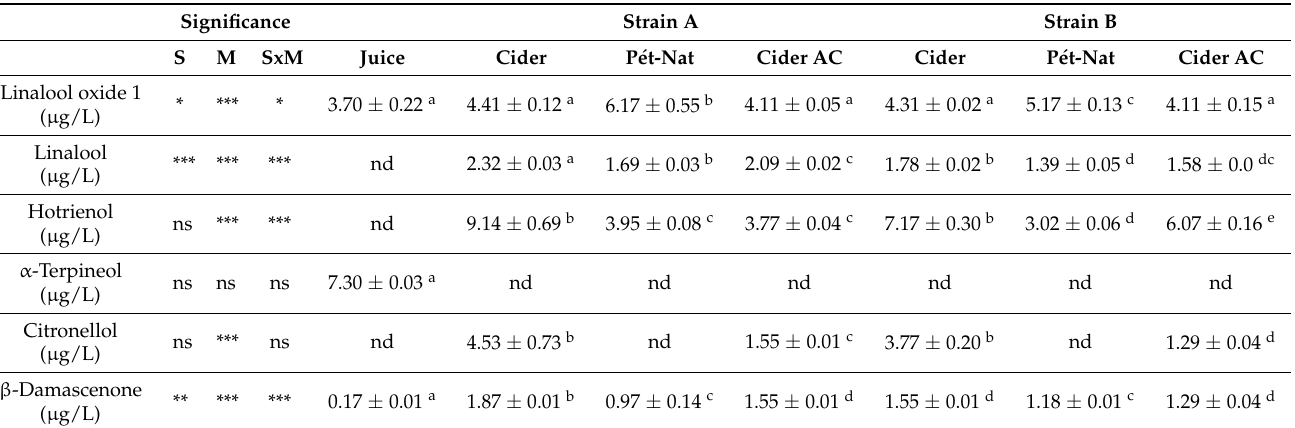
Table 2. Terpenes and norisoprenoids in ciders produced with two different strains of T. delbrueckii and different fermentation methods aimed to produce sparkling